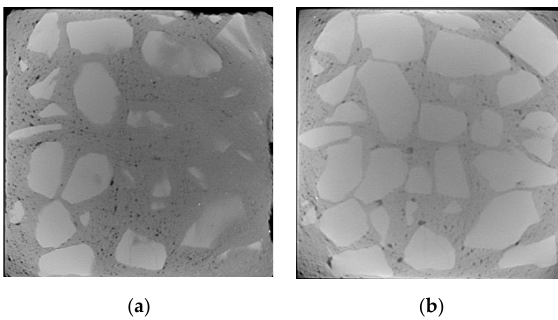
Figure 6. CT images of D5 before sulfate attack (no cracks): ( a ) surface layer; ( b ) inner layer.